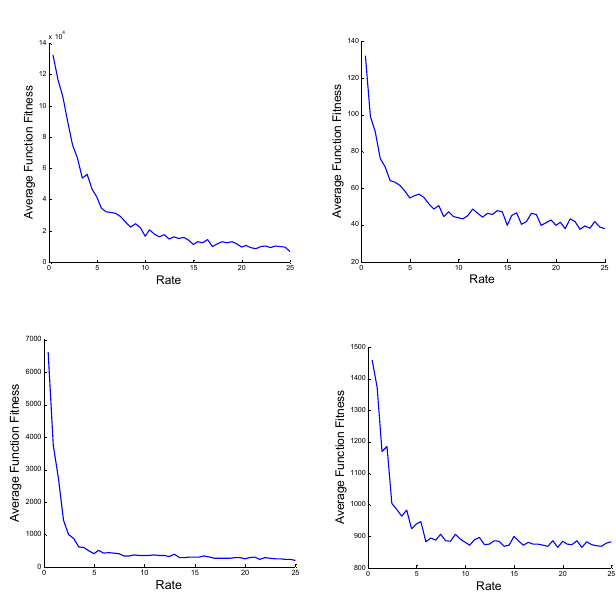
Figure 1. Impact of Harmony Memory Size (HMS) with 30 runs on the aHSDE (f1, f10, f21, f28).